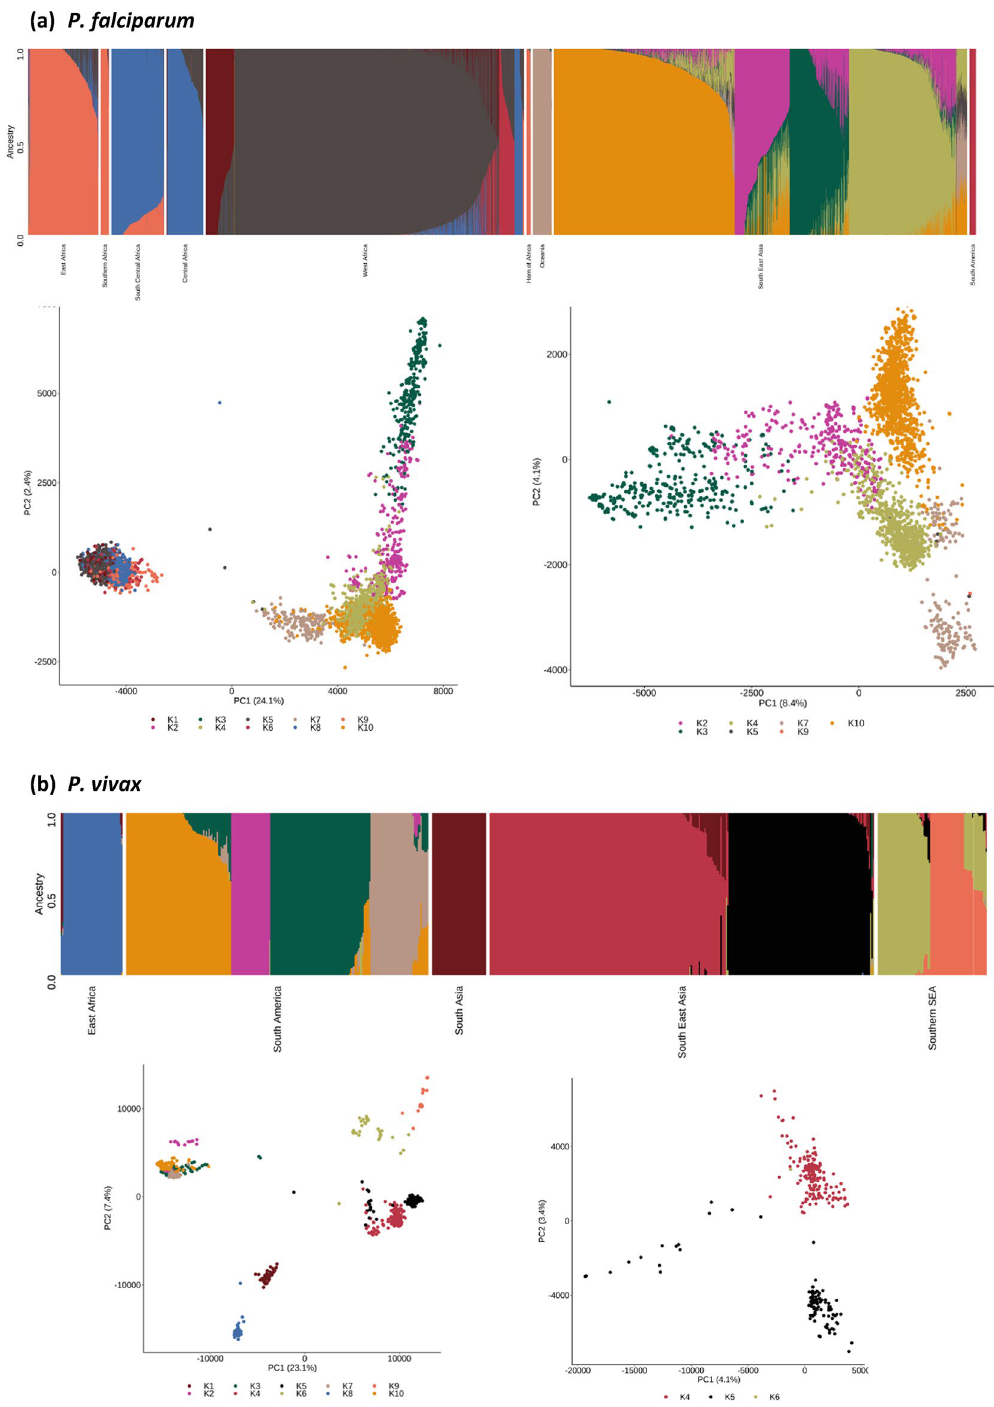
Figure 2. ADMIXTURE analysis involving 10 inferred ancestral populations (denoted as K1 to